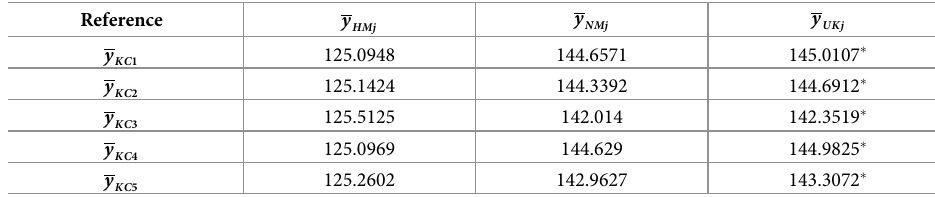
Table 2. PREs for the apple production dataset